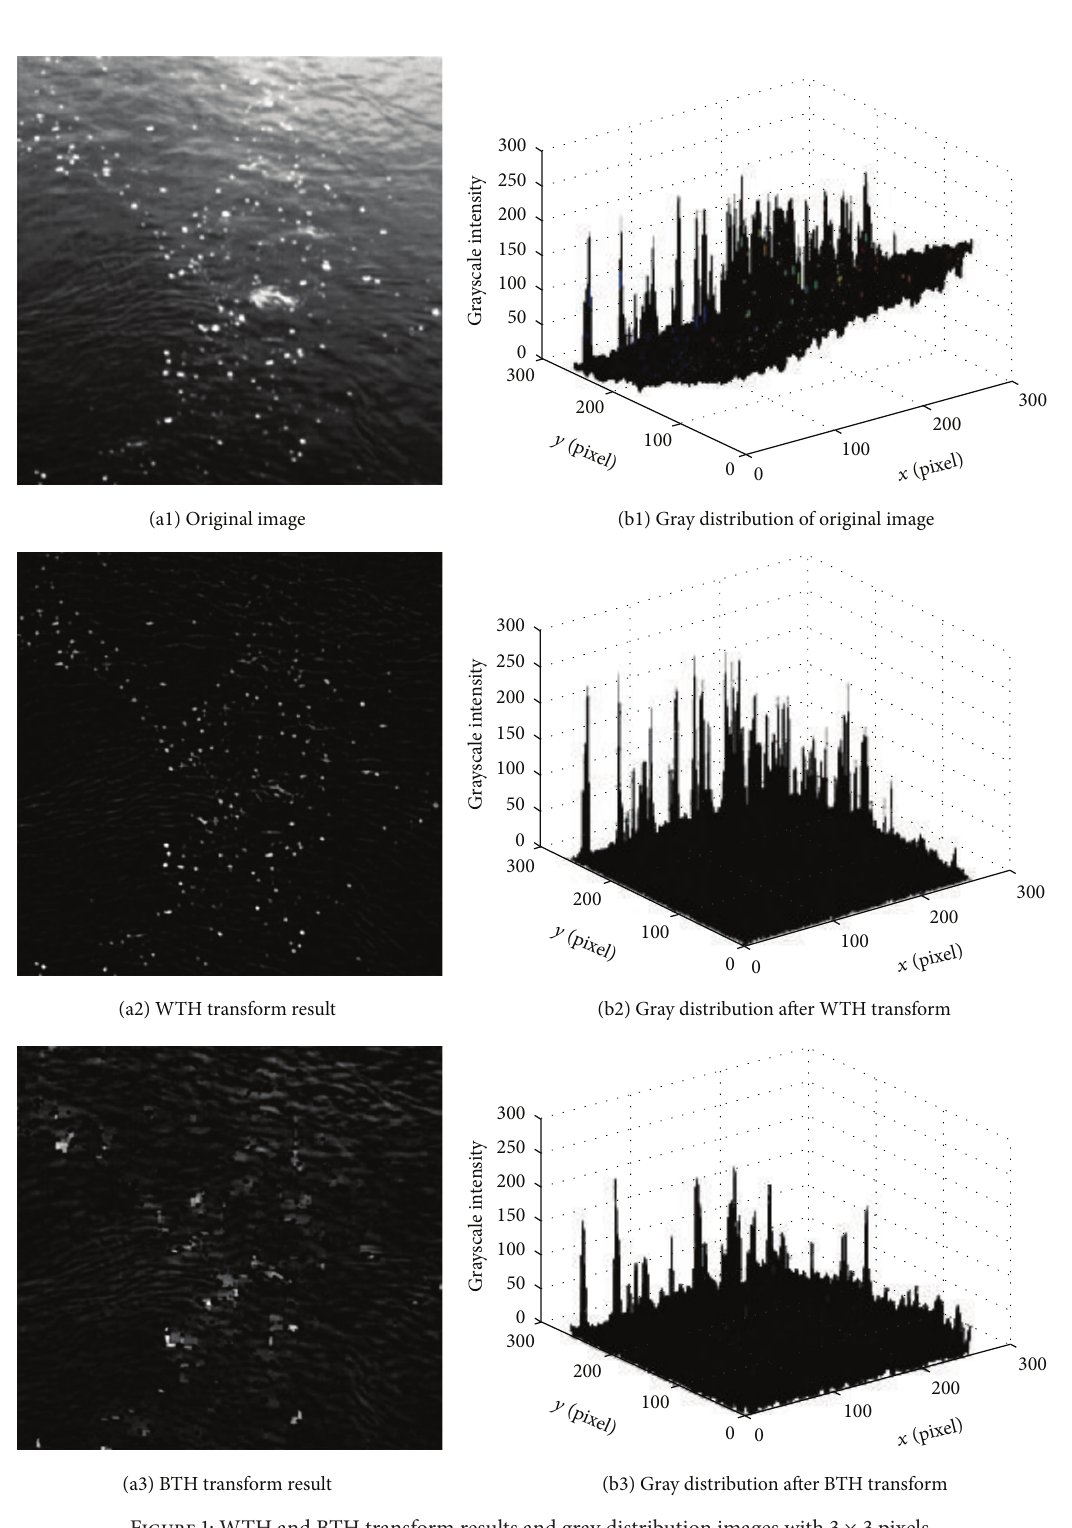
Figure 1: WTH and BTH transform results and gray distribution images with 3 × 3